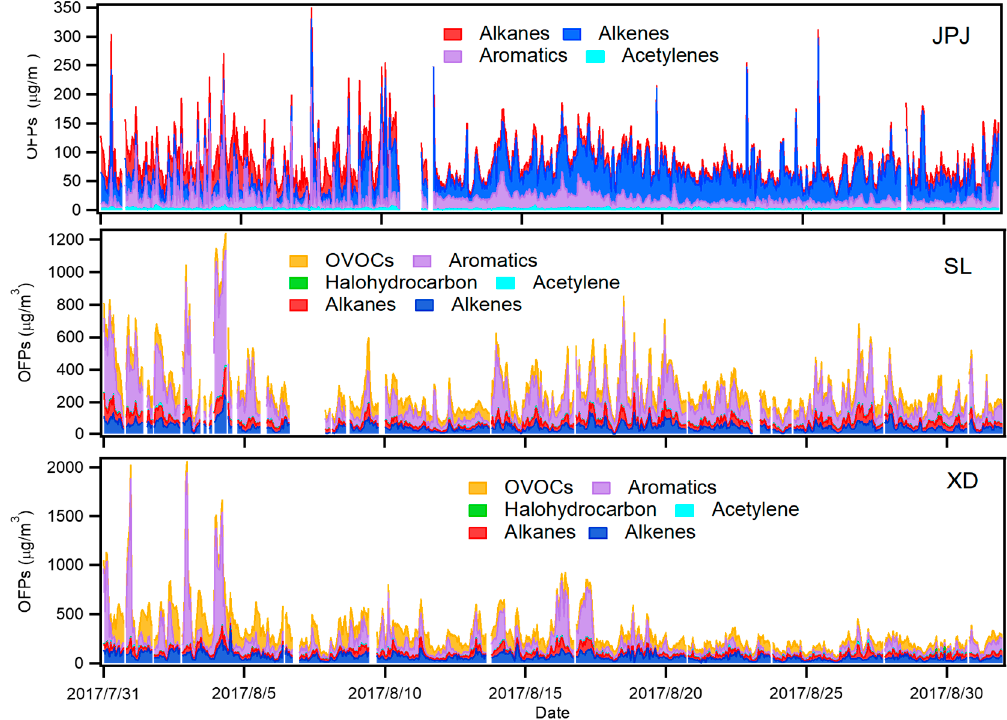
Figure 6. Contribution of various VOC groups to ozone formation potentials (OFPs) at each study site.